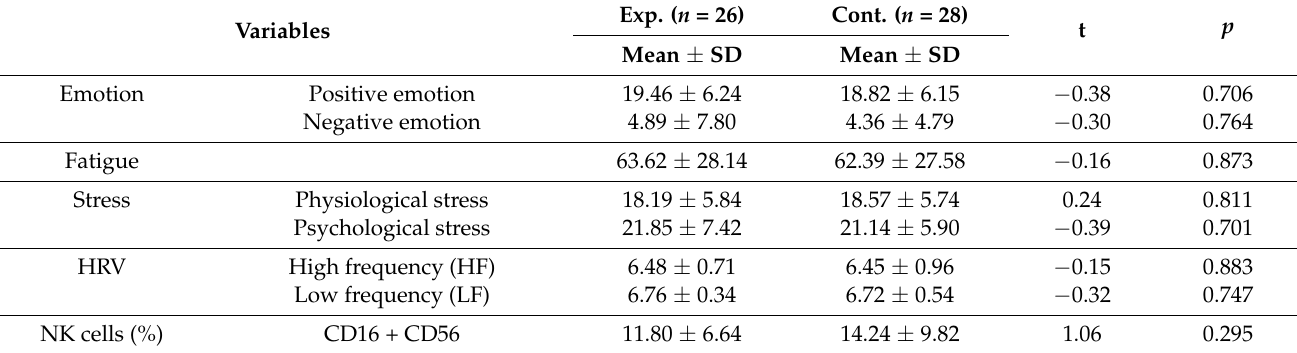
Table 4. Values of dependent variables for the groups ( n = 54).